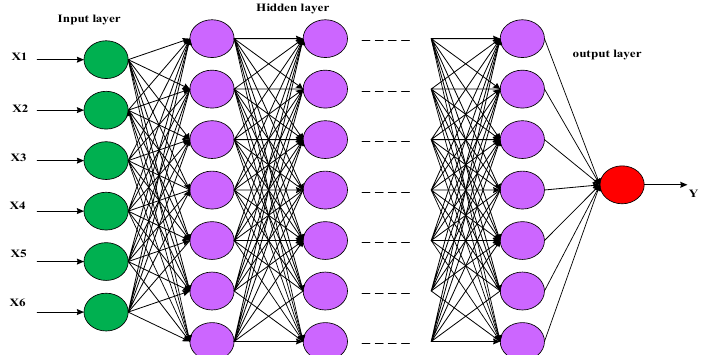
Figure 2. Proposed IDNN Structure.